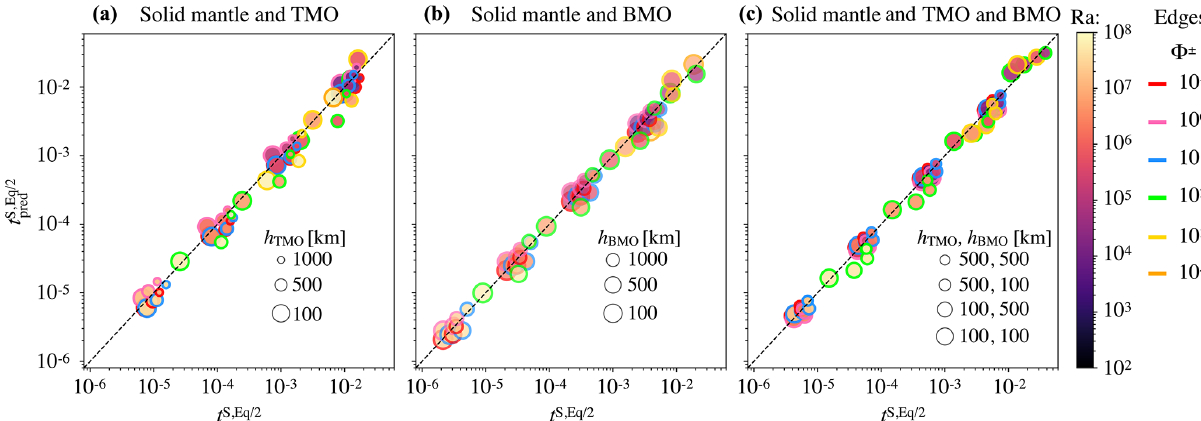
Figure A1. Regression for all data with Eq. (15) for the solid mantle bounded by (a) a TMO of 1000, 500, and 100km ( V S = 4 . 7 × 10 20 , 6 . 7 × 10 20 , and 8 . 6 × 10 20 m 3 respectively); (b) a BMO of 1000, 500, and 100km ( V S = 7 . 1 × 10 20 , 8 . 2 × 10 20 , and 8 . 9 × 10 20 m 3 respectively); and (c) a TMO and BMO of 500–500, 500–100, 100–500, and 100–100km ( V S = 5 . 8 × 10 20 , 6 . 6 × 10 20 , 7 . 7 × 10 20 , and 8 . 4 × 10 20 m 3 respectively). Colours indicate the corresponding Rayleigh number, Ra , and coloured outlines represent the phase change number, (cid:56) .